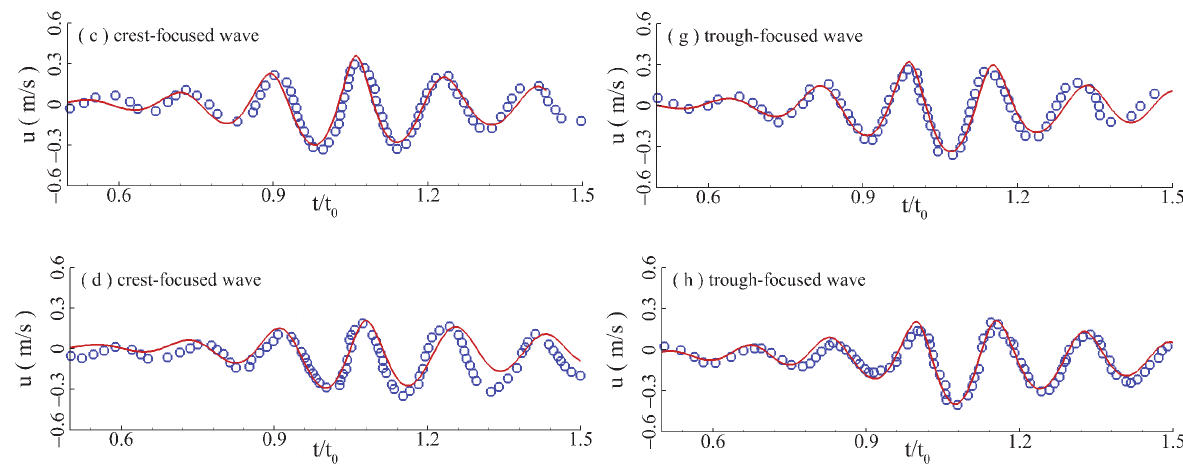
Figure 2. Comparisons of the horizontal velocities obtained numerically with the experimental results; left side: crest-focused wave; right side: trough-focused wave; ( a , e ) Run1; ( b , f ) Run2; ( c , g ) Run3; ( d , h ) Run4.